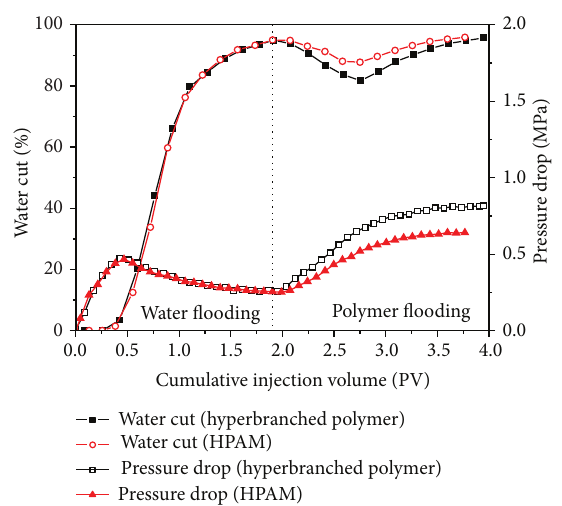
Figure 11: EOR results of the HPAM and hyperbranched polymer solutions at 80 ∘